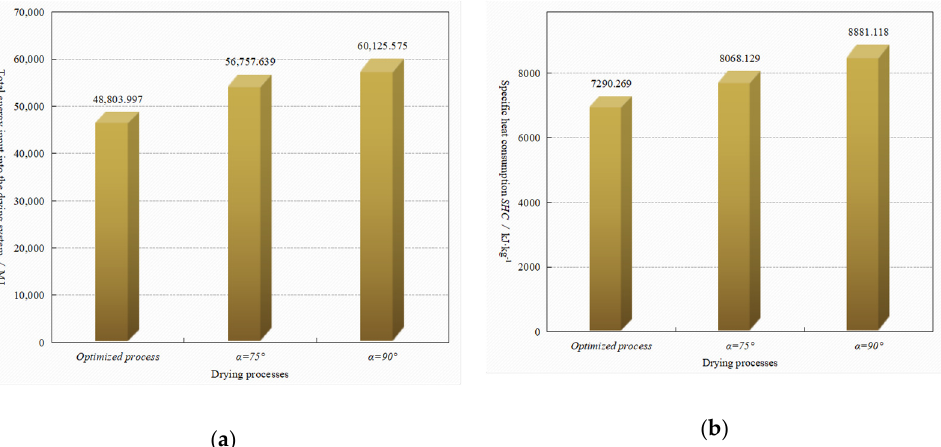
Figure 8. The total energy input into the drying system ( a ) and the specific heat consumption ( b ) of the drying system for the three drying processes.